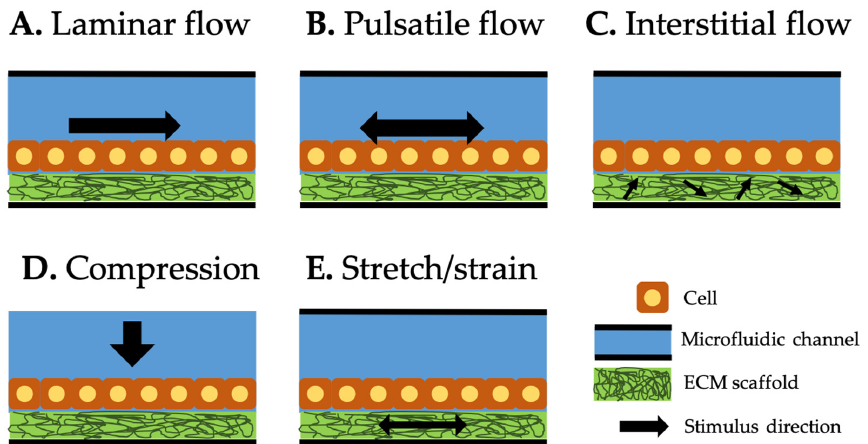
Figure 1. Types of mechanical stimuli integrated in organ-on-a-chip (OOC) systems. Black arrow represents the direction of each stimulus. Laminar ( A ) and pulsatile ( B ) flows along the microfluidic channel and generates laminar and pulsatile shear stresses on the cell surfaces. Interstitial flow ( C ) through the extracellular matrix (ECM) scaffold generates the shear stress to the cells attached to it. Compression ( D ) generates compressive force on top of the cells. Stretch/strain applied to the ECM scaffold ( E ) generates the force to the cells attached to it.